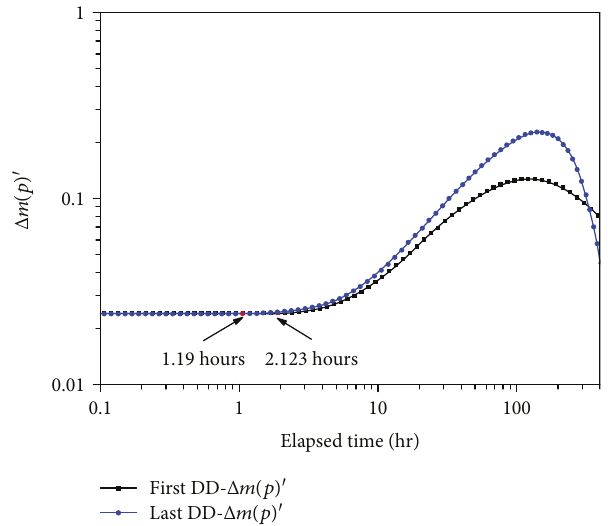
Figure 22: The interpretation result of the fi rst DD and last DD. For the fi rst DD, from 2.123 hours, the pressure reaches saturation front, but for the last DD, the time of pressure reaching saturation front is about 1.190